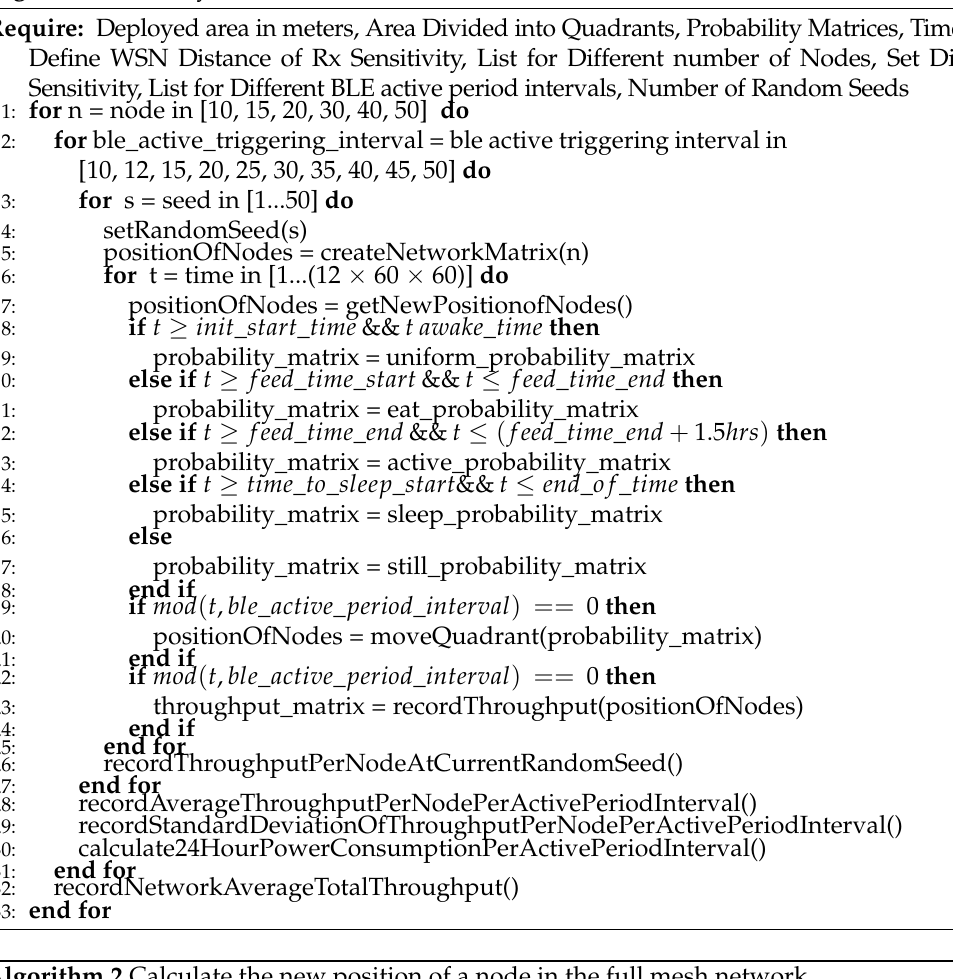
Algorithm 1 BLE dynamic node simulator for a full mesh network